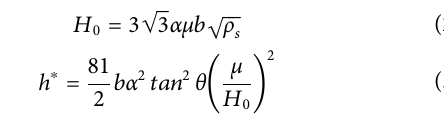
Frontiers in Materials |